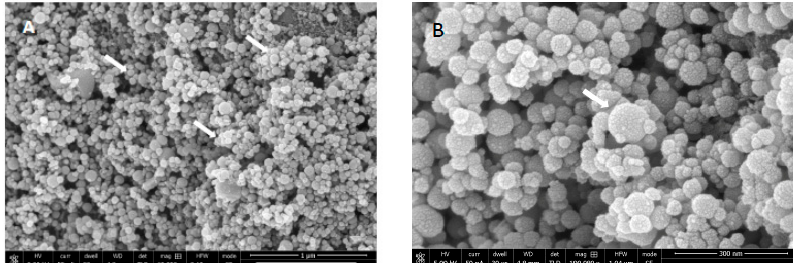
Figure 1. Field emission scanning electron microscopic (FESEM) micrograph under ( A ) low and ( B ) high magnification showing hydroxyapatite nanoparticle agglomerates with round morphology. The white arrowhead in Figure 1B, clearly showing the spherical HA nanoparticle. Coatings 2020 , 10 , x FOR PEER REVIEW